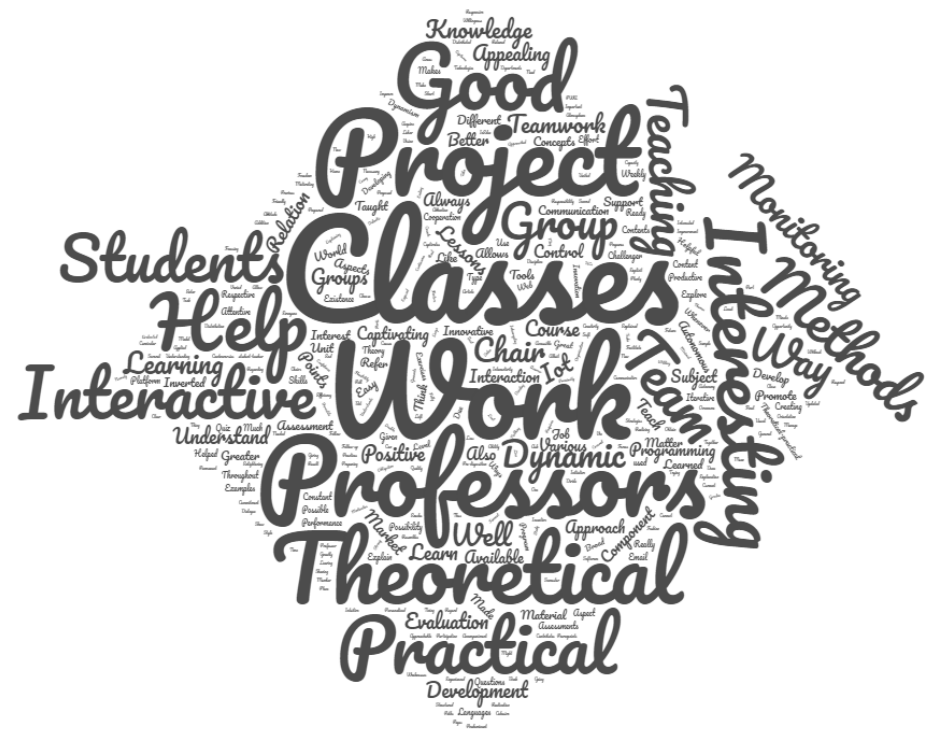
Figure 6. Improvements needed at the